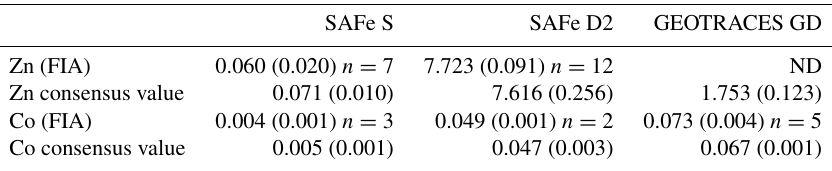
Table 1. Analytical validation results for open-ocean surface seawater (SAFe S), 1000m seawater (SAFe D2) and 2000m seawater (GEO- TRACES GD). All concentrations are in nanomolar ( ± 1 std. dev.). Consensus value conversion = 1.025kgL − 1 . FIA: flow injection analysis. ND indicates sample not